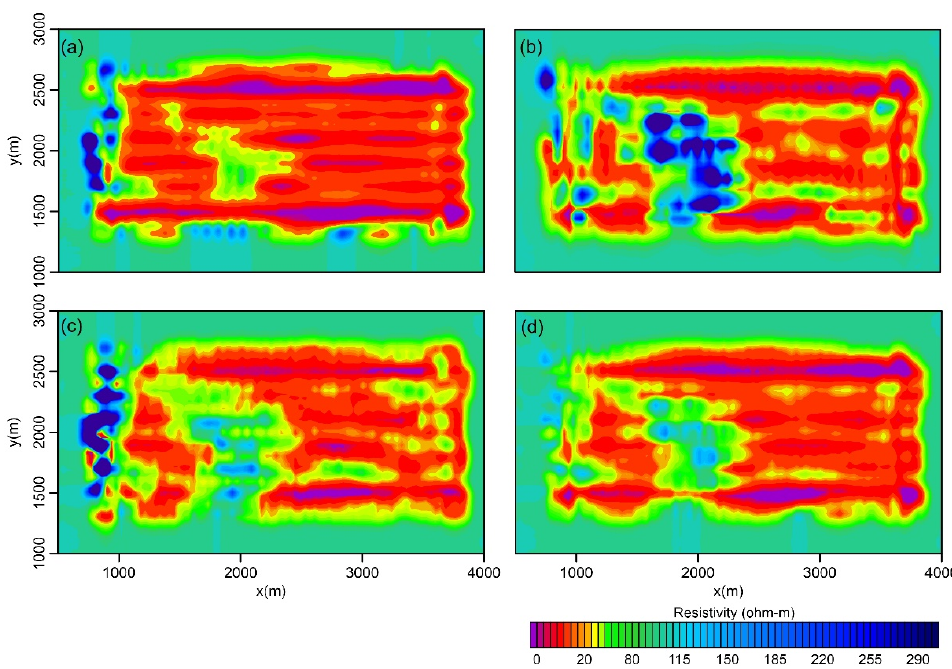
Figure 13. Comparison of anisotropic and isotropic inversions for the field data. ( a ) and ( b ) show the inverted ρ x and ρ y for an anisotropic model; ( c ) shows the inverted resistivity for an isotropic model, while ( d ) shows the equivalent resistivity ρ h calculated from the ρ x and ρ y for the anisotropic model (all the slices are the horizontal slices at z = 44 m).